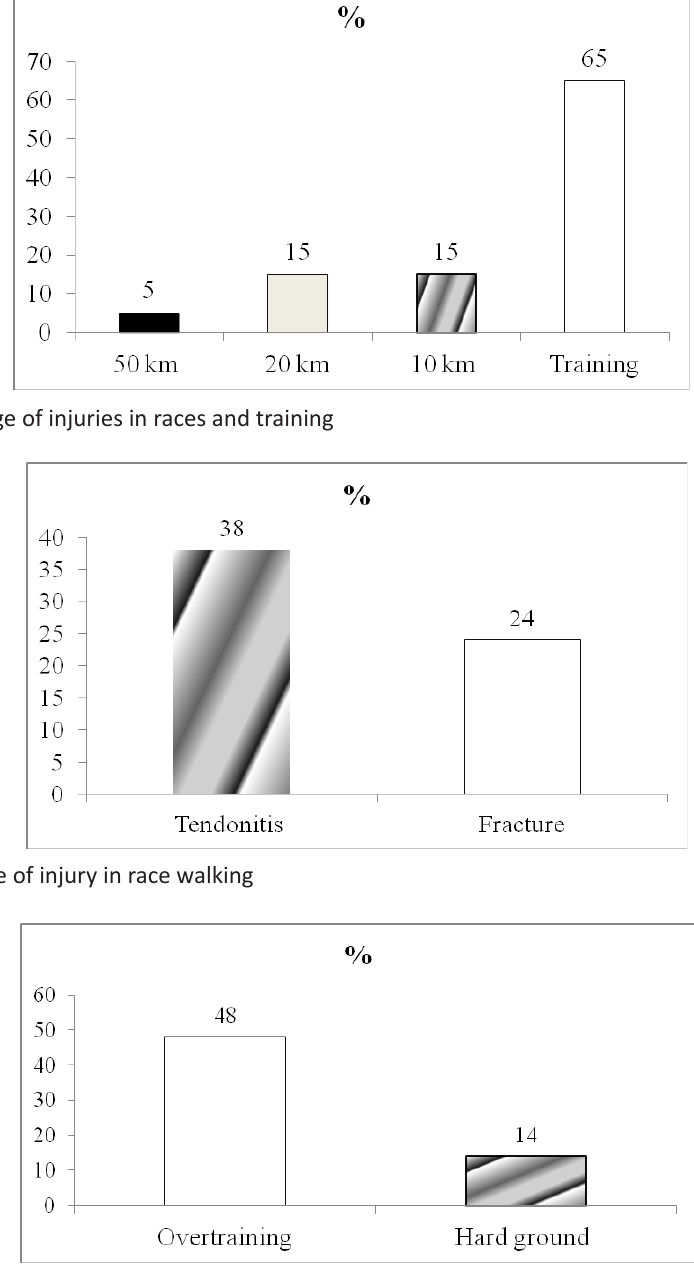
Figure 7. T he common causes of the